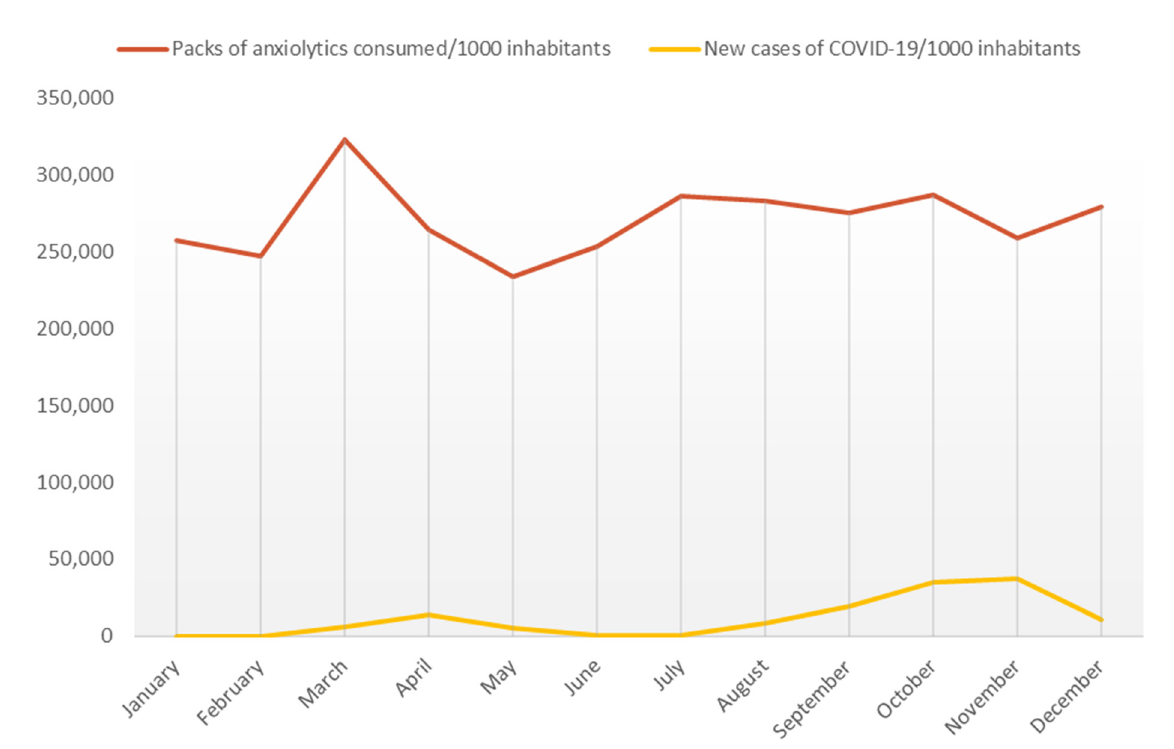
Figure 3. Progression of the new cases of COVID-19 per 1000 inhabitants in Castile and Leon in comparison with number of packs of anxiolytics consumed per 1000 inhabitants in Castile and Leon.